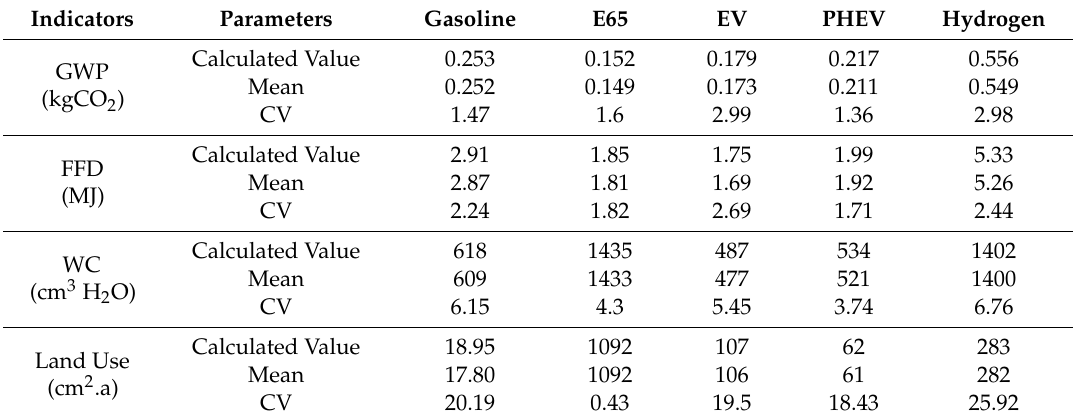
Table 11. Uncertainty analysis (based on FU per